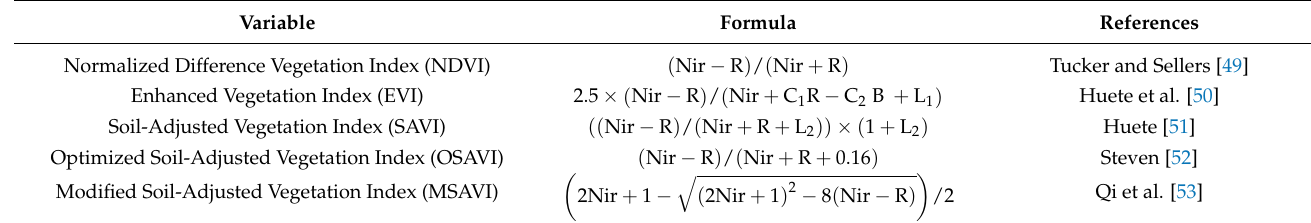
Table 2. Vegetation index calculation formula and